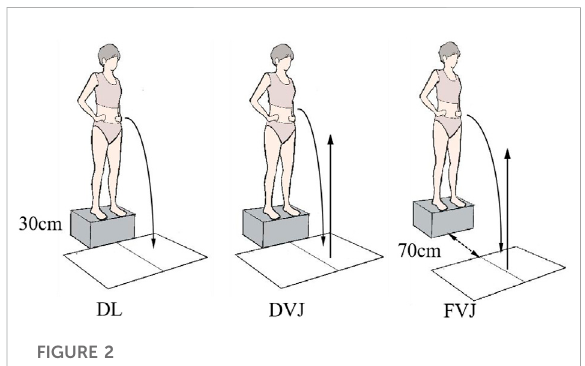
FIGURE 2 DL, DVJ and FVJ landing test action. FIGURE 3